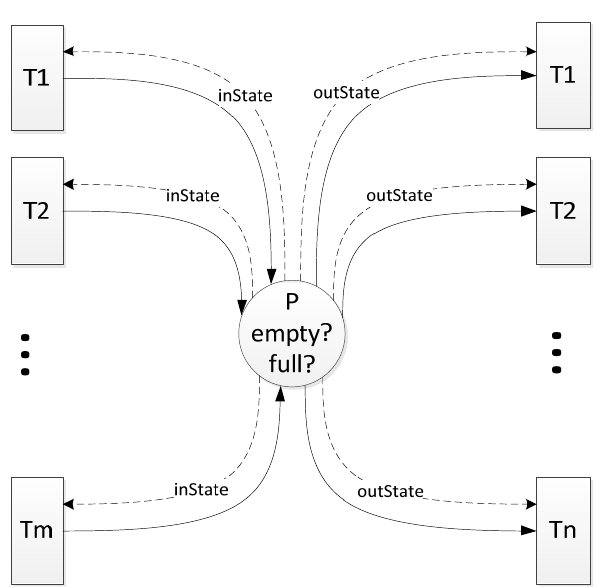
Figure 10: The connector variables inState and outState of a Place are reported to the connected